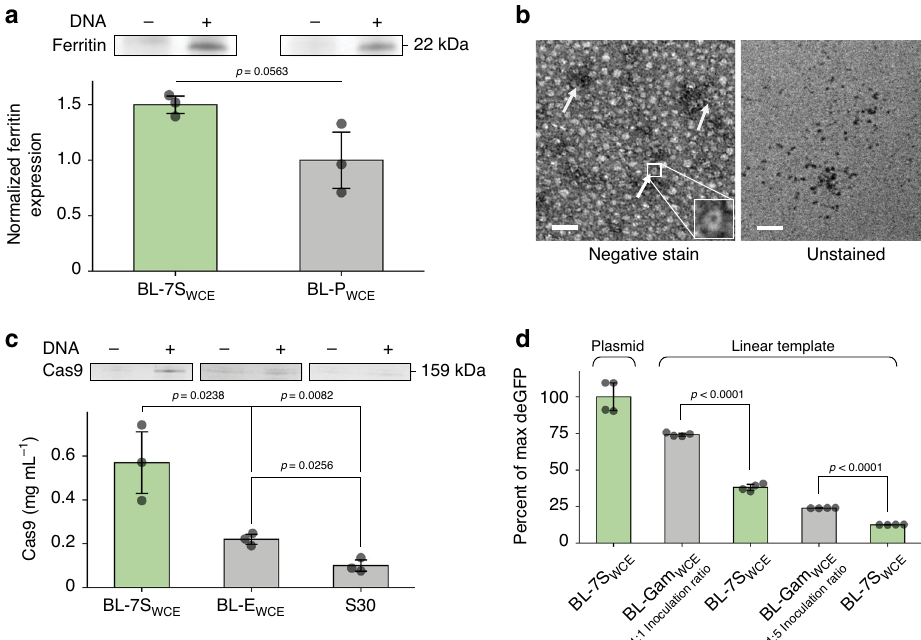
Fig. 4 Enhanced CFPS as a versatile tool for the expression of diverse proteins. a CFPS of ferritin using BL-7S WCE and BL-P WCE . The bar chart shows that the expression of ferritin in reactions assembled using BL-7S WCE is ~0.5-fold higher than the expression achieved using BL-P WCE . Standard two-tail t -test ( n = 3 independent experiments). Top panel: representative SDS-PAGE results of CFPS reactions expressing ferritin ( + ) and negative control without plasmid ( − ). See Supplementary Fig. 10. for the SDS-PAGE analysis of all the CFPS reactions. b TEM images of ferritin nanocages. The left image shows the